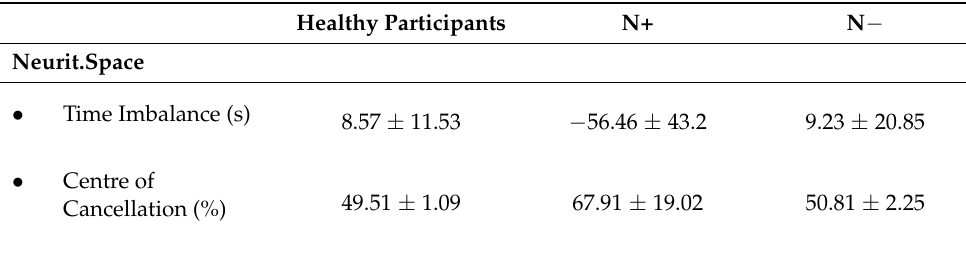
Table 3. Means ± standard deviations of the performances of healthy participants and patients at the new parameters of the computerized tests (time of imbalance and